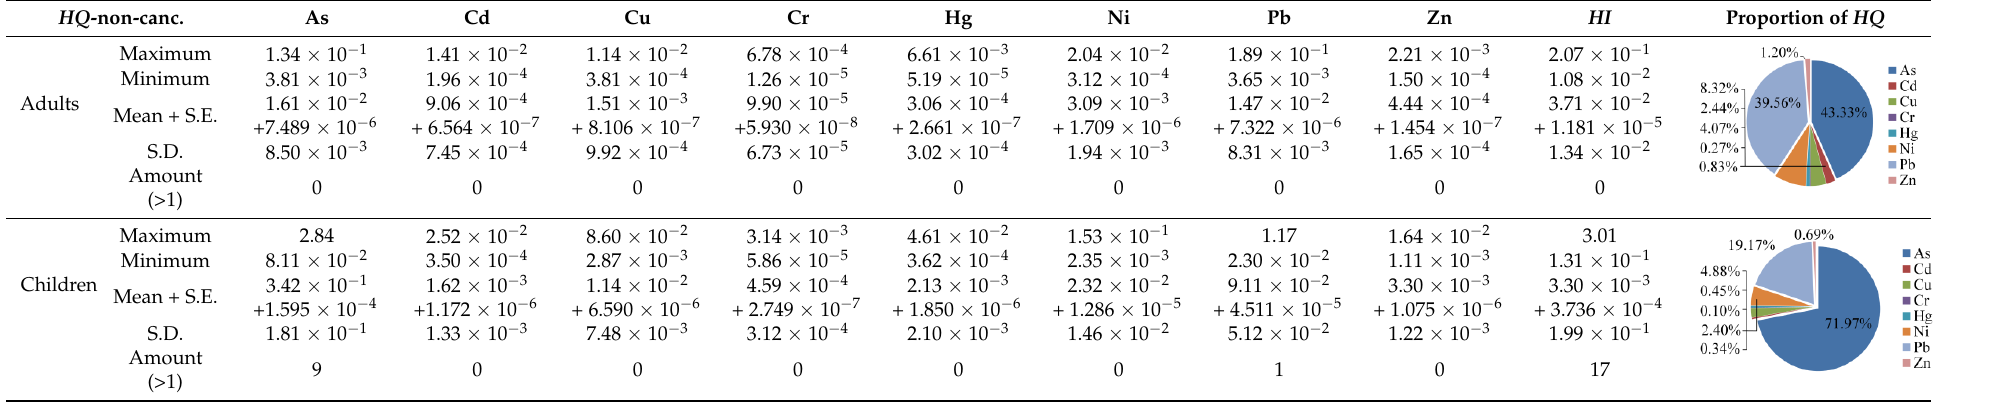
Table 6. HQ and HI assessments of health risks posed to adults and children by soil in the study area. HQ -non-canc.